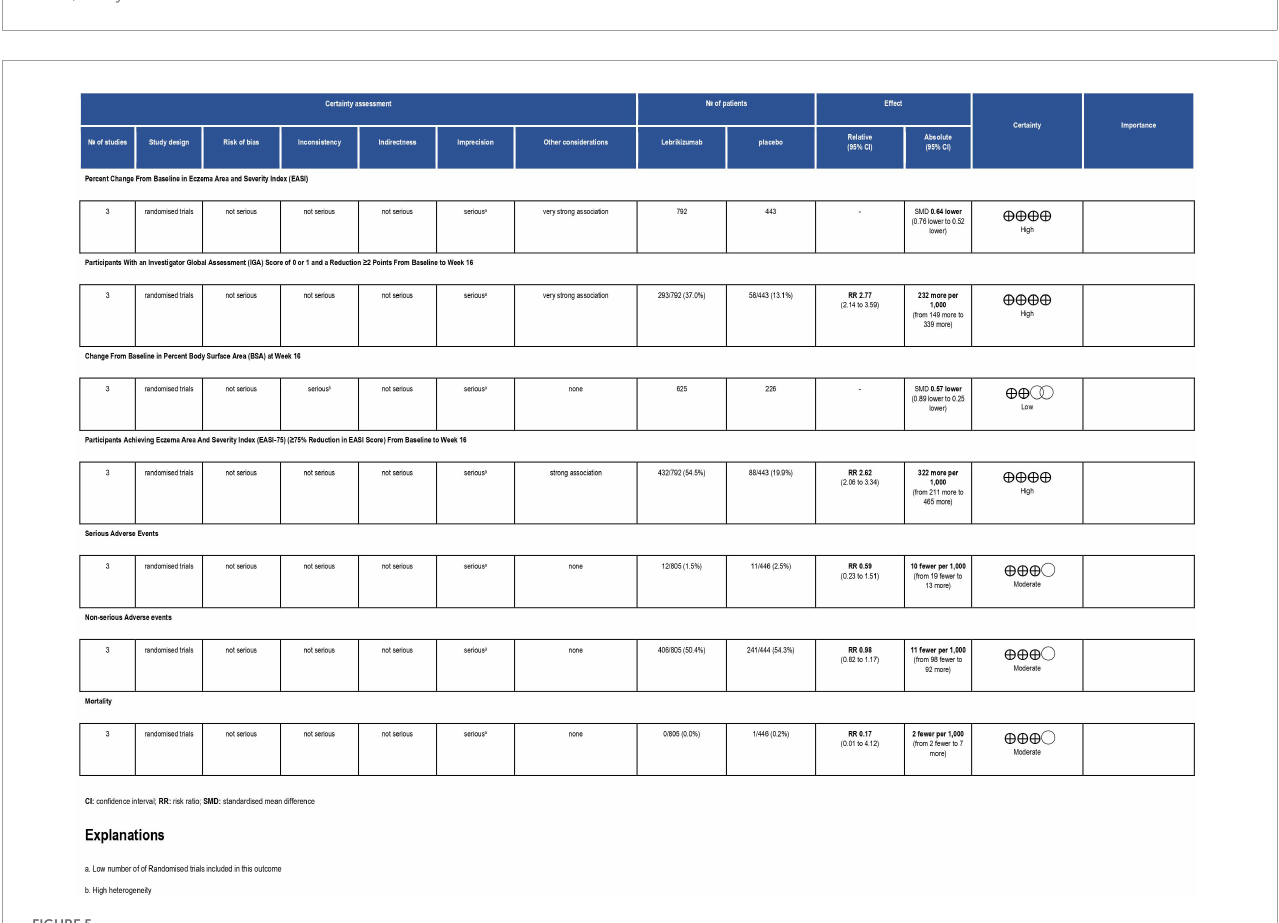
inducing SAEs that nearly matched to placebo (RR = 0.59, 95% CI [0.23, 1.51], p = 0.27, I 2 = 7%). Both the first (RR = 0.72, 95% CI [0.18, 2.90], p = 0.65, I 2 = 38%) and the second (RR = 0.71, 95% CI